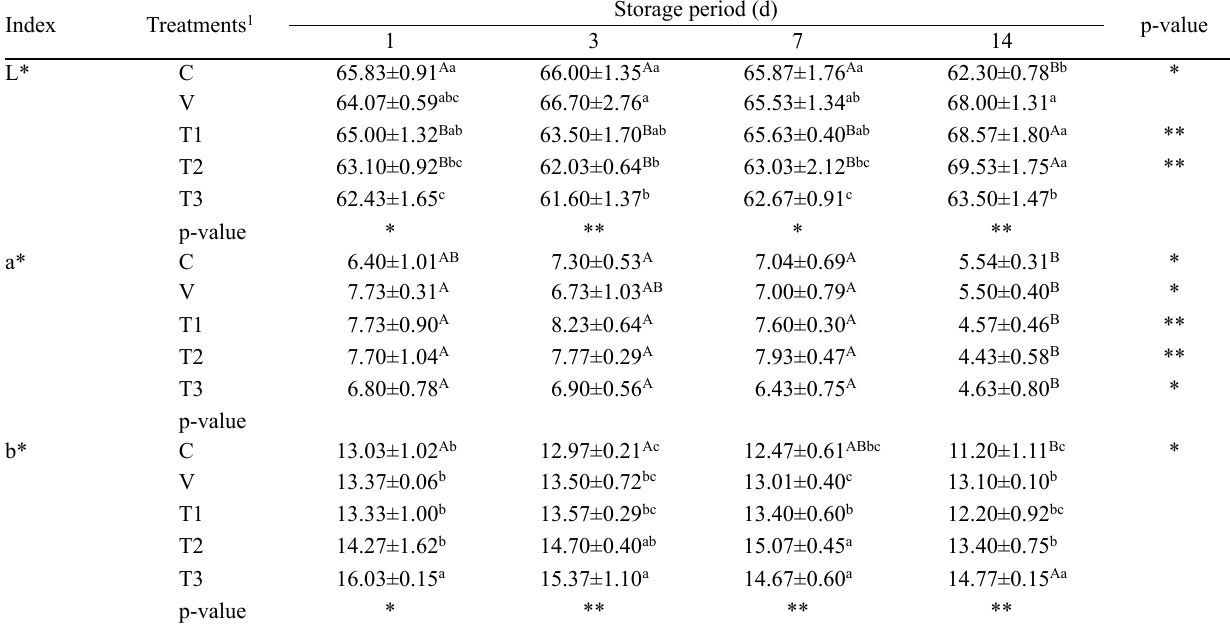
Table 4. Changes in the color of uncooked pork patties mixed with VAL ethanol